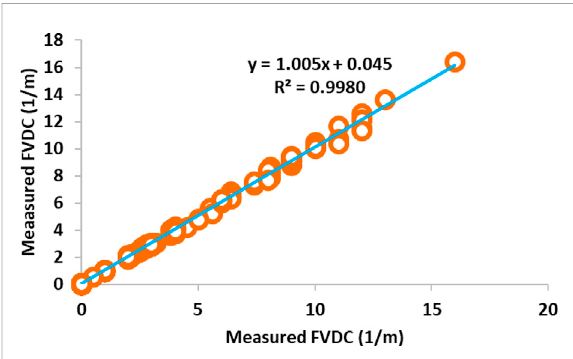
FIGURE 17 llustration of cross plot of new robust LSSVM-PSO algorithm structered by training subset of well #W1 for prediction FVDC related to wells